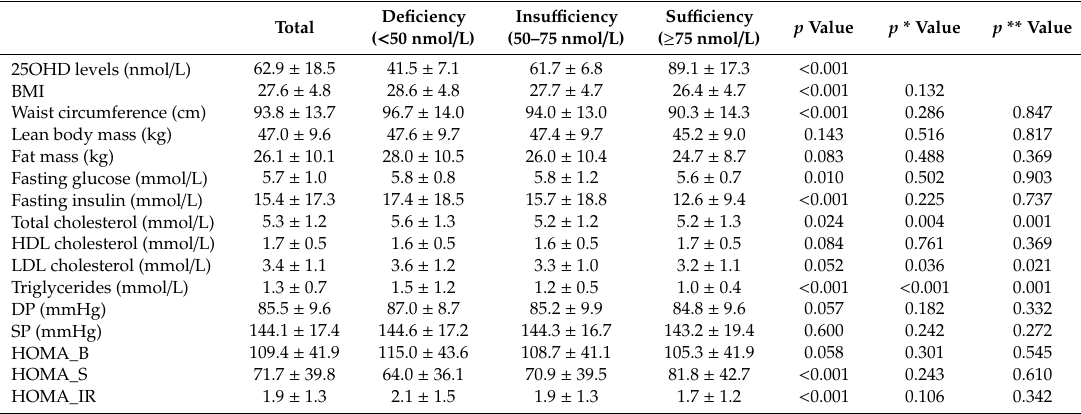
Table 2. Baseline anthropological and biochemical characteristics of the subjects by 25OHD